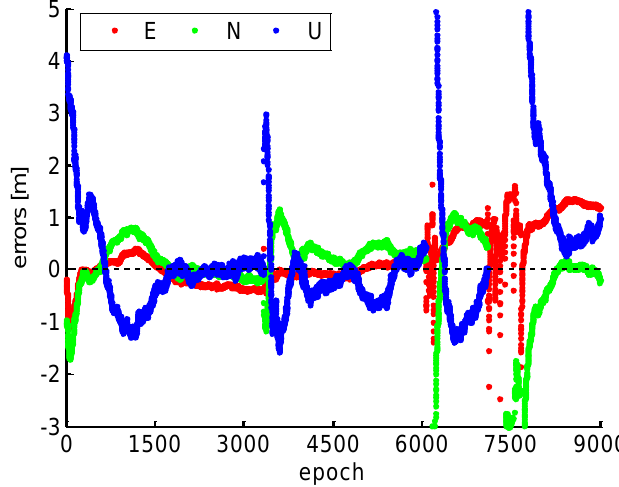
Figure 14. Position errors by the conventional PPP.